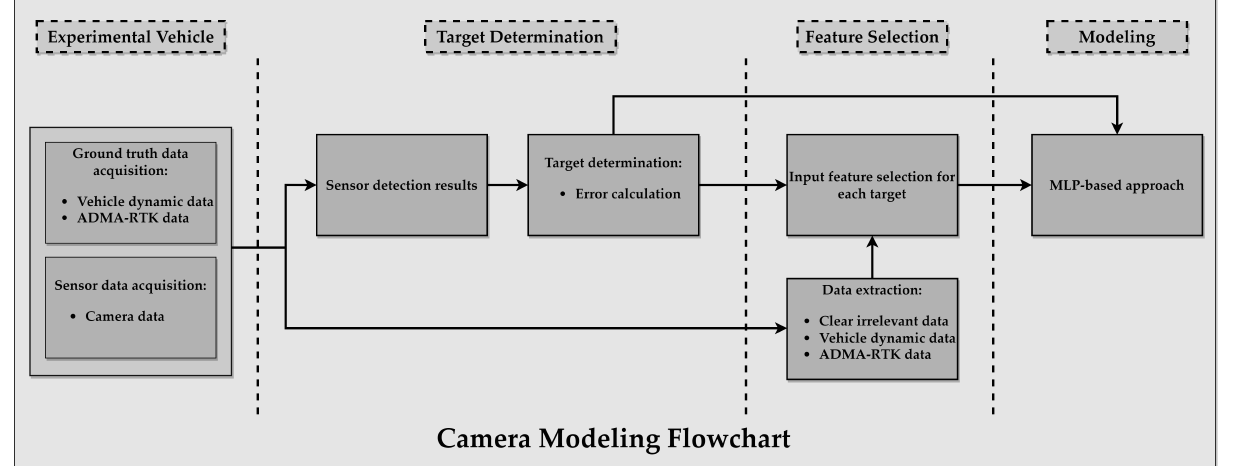
Figure 4. Schematic representation of necessary components for camera